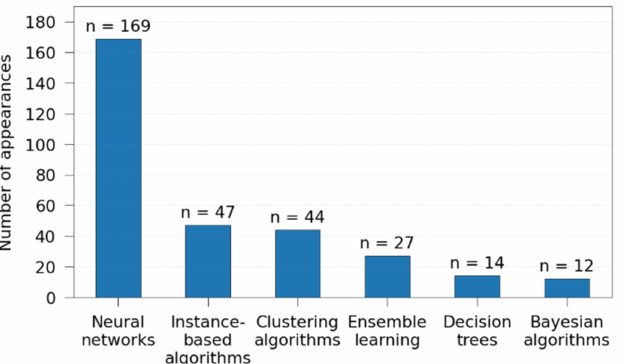
Figure 4. ML techniques. The number of appearances of each technique within the cluster of ML techniques is displayed. Supervised learning with ANN is the predominant ML technique. Clustering algorithms are frequently used for data preparation and feature selection. Decision trees and Bayesian networks are used rather rarely.